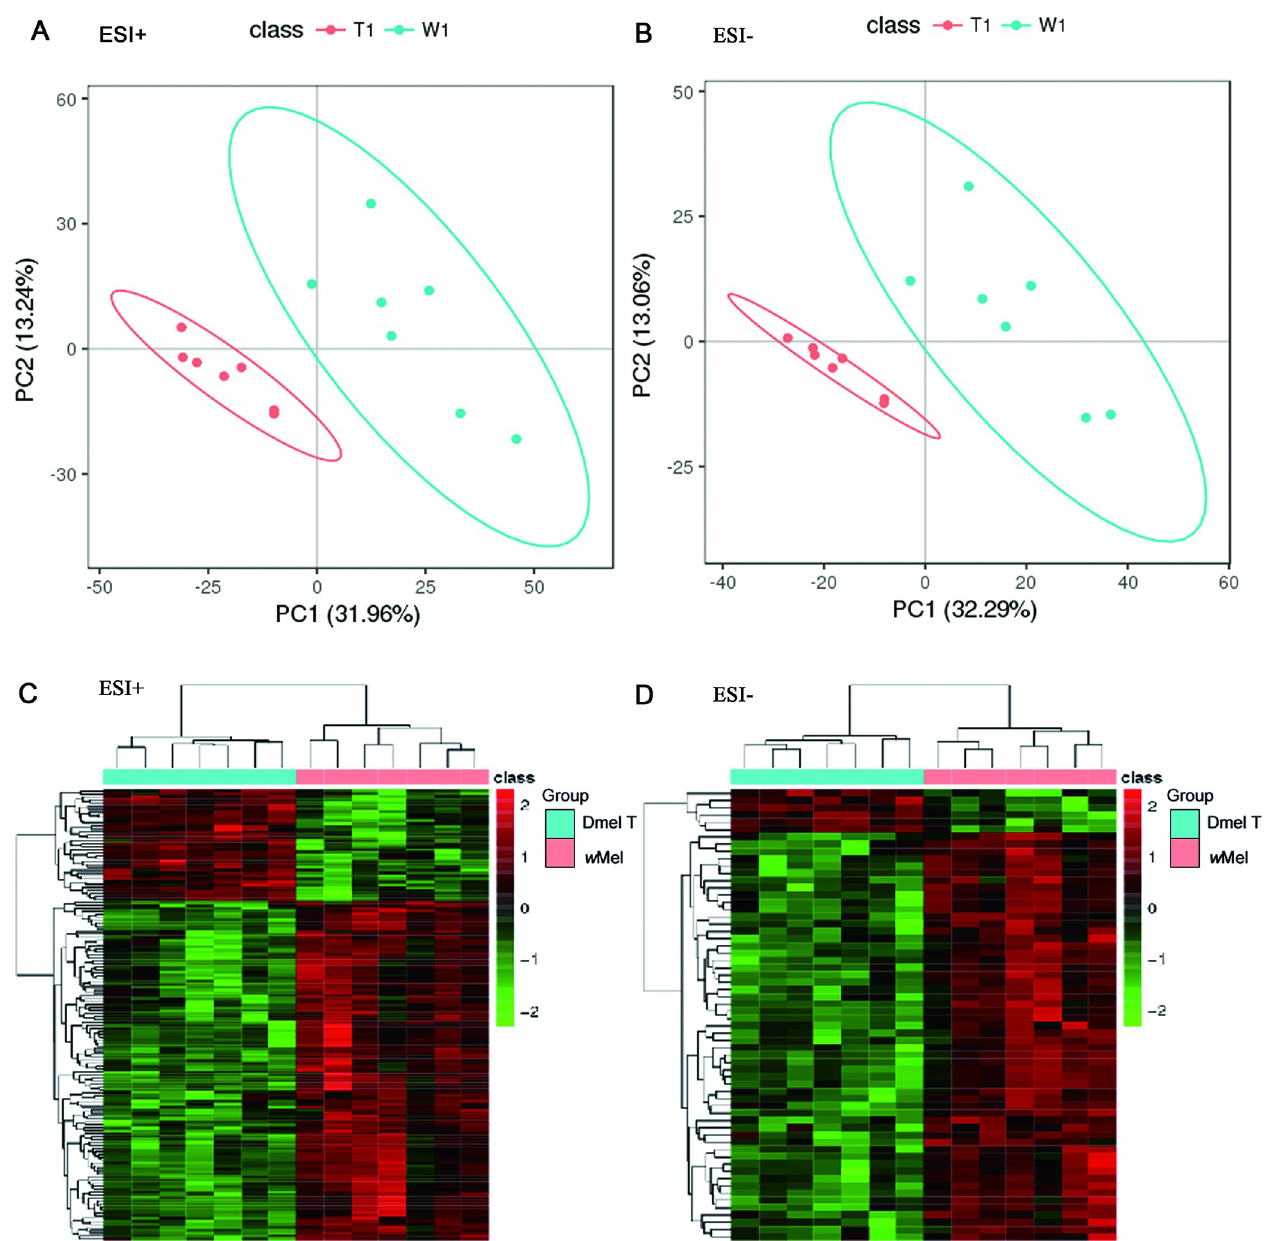
Fig 1. Multivariate statistical analysis of metabolomics data. Score plots of PLS-DA model in positive ion mode (A) and negative ion mode (B). Clustering analysis of differential ion in ESI+ (C) and ESI- (D). Dmel T: uninfected flies; w Mel: Wolbachia -infected flies.